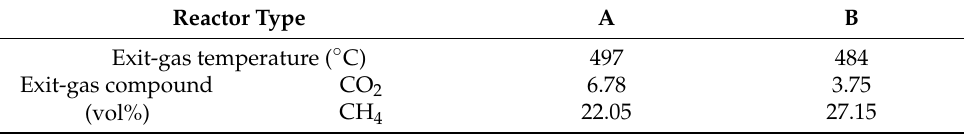
Figure 3. Reacting-flow simulation for the B-type reactor. Table 1. Composition of temperature and exhaust gases according to reactor